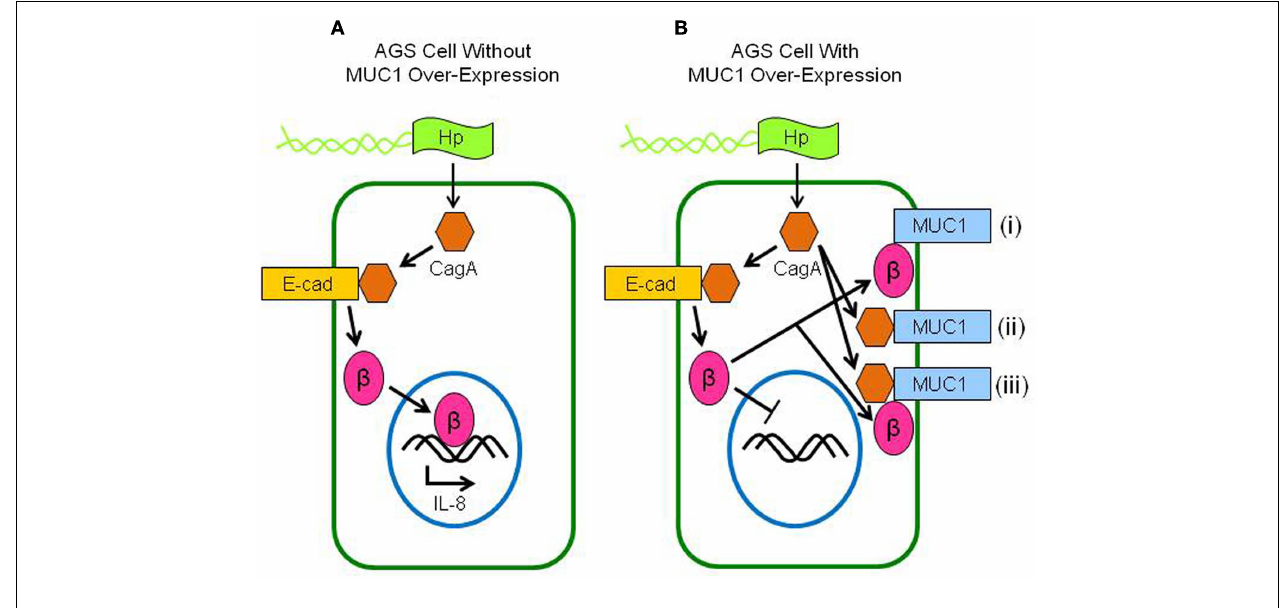
to translocate to the nucleus and activate IL-8 gene expression. (B) With MUC1 over-expression, β -catenin that is displaced by CagA binds to MUC1 (i), thus blocking its nuclear translocation and attenuating IL-8 production. CagA also binds to MUC1, possibly either without (ii) or with (iii) β